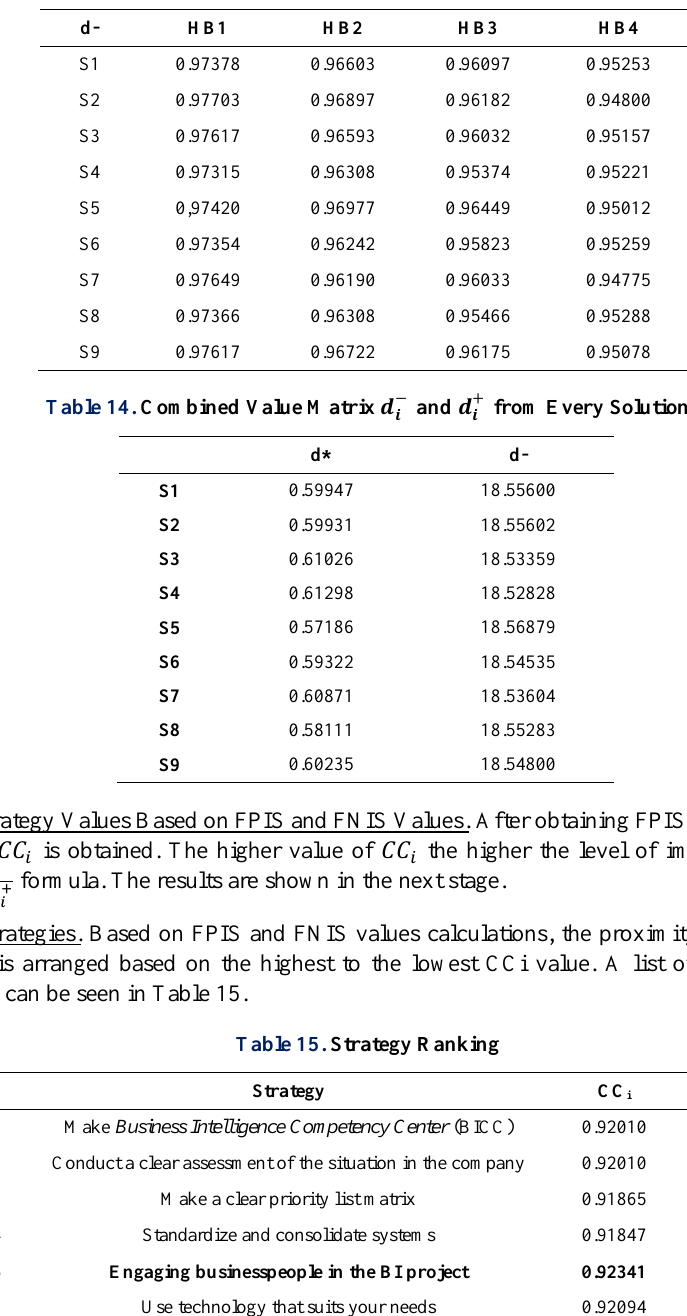
Table 13. Matrix 𝒅 𝒊− Strategy for Process/Business Barriers